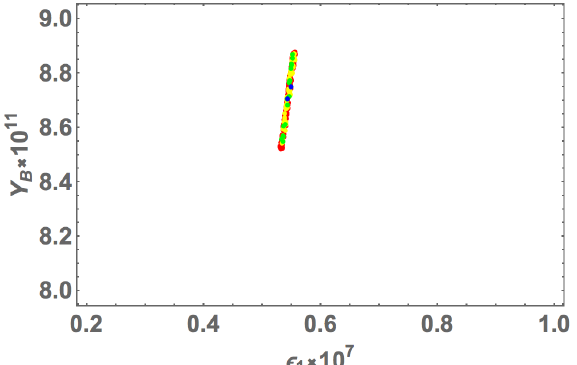
Figure 6 . Allowed region of the baryon asymmetry Y B in terms of the CP asymmetry source (cid:15) 1 , where the color legends are the same as the one in figure 1 and the Y B is taken within the observed range in eq.